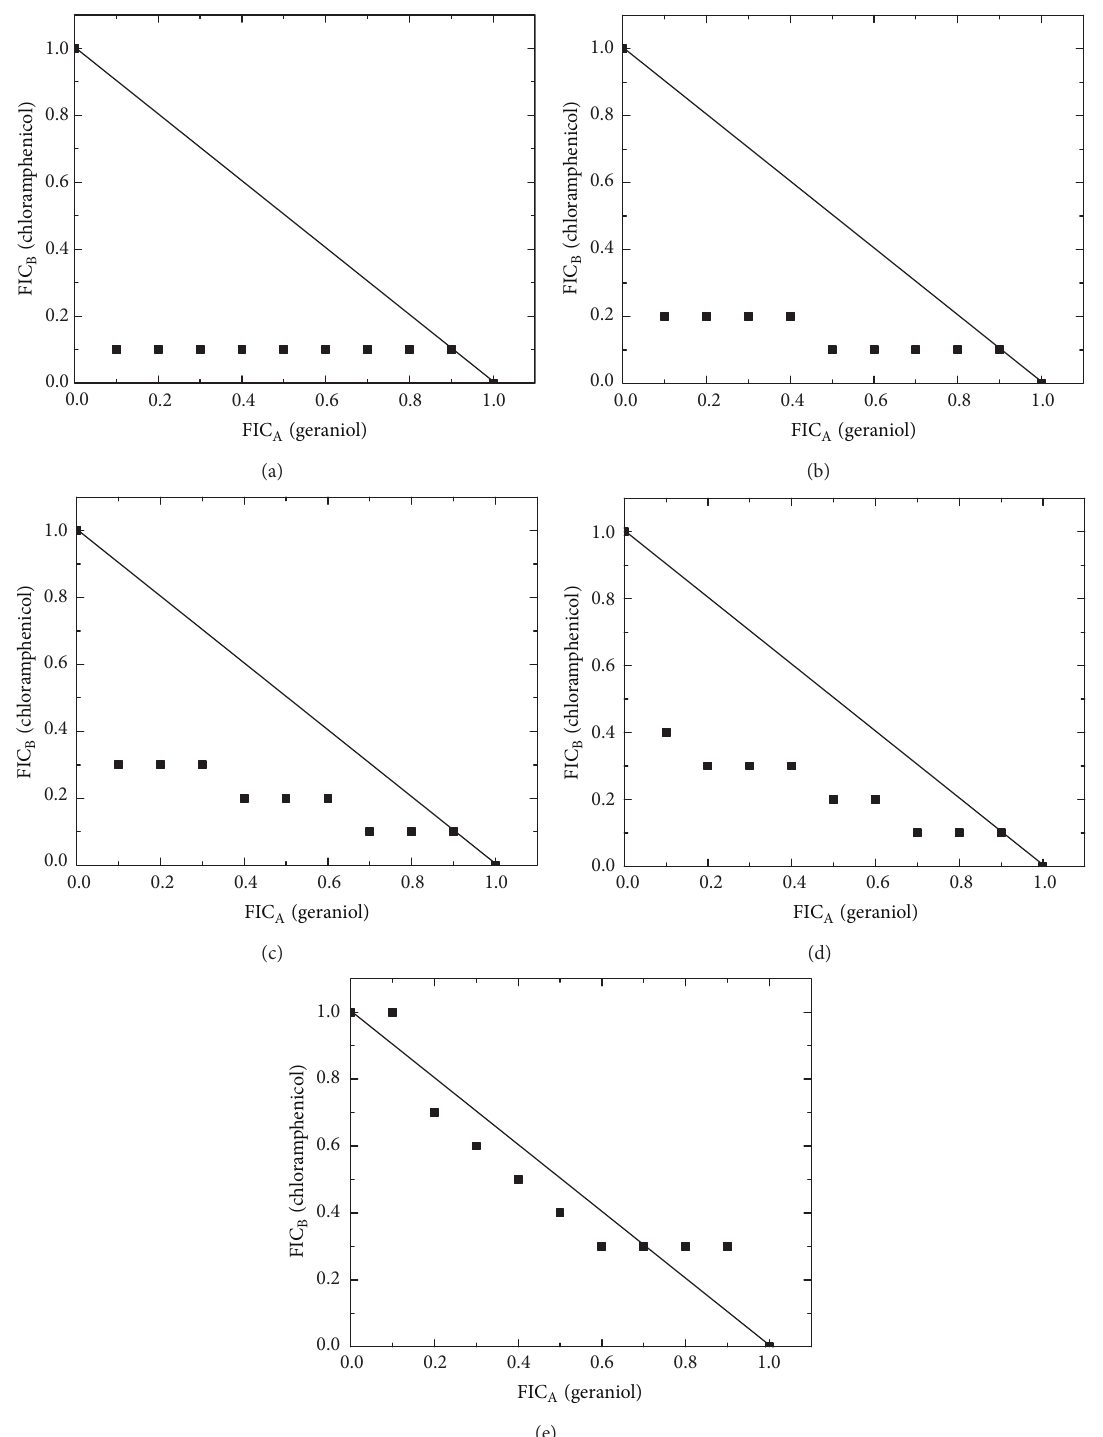
Figure 2: The derived isobolograms for the interaction of geraniol-chloramphenicol and their treatment outcomes against the following: (a) E. coli ATCC 25922, (b) K. pneumoniae ATCC 700603, (c) P. mirabilis ATCC 12453, (d) P. aeruginosa ATCC 27853, and (e) S. aureus ATCC